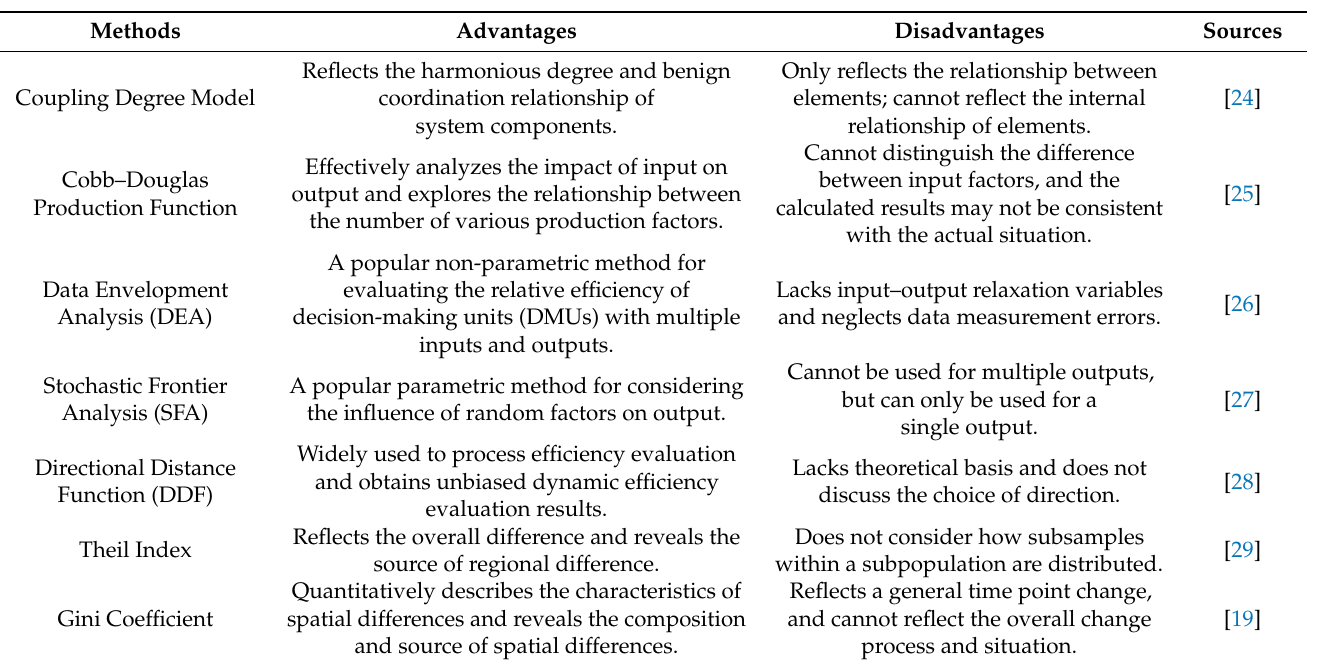
Table 1. Methods of